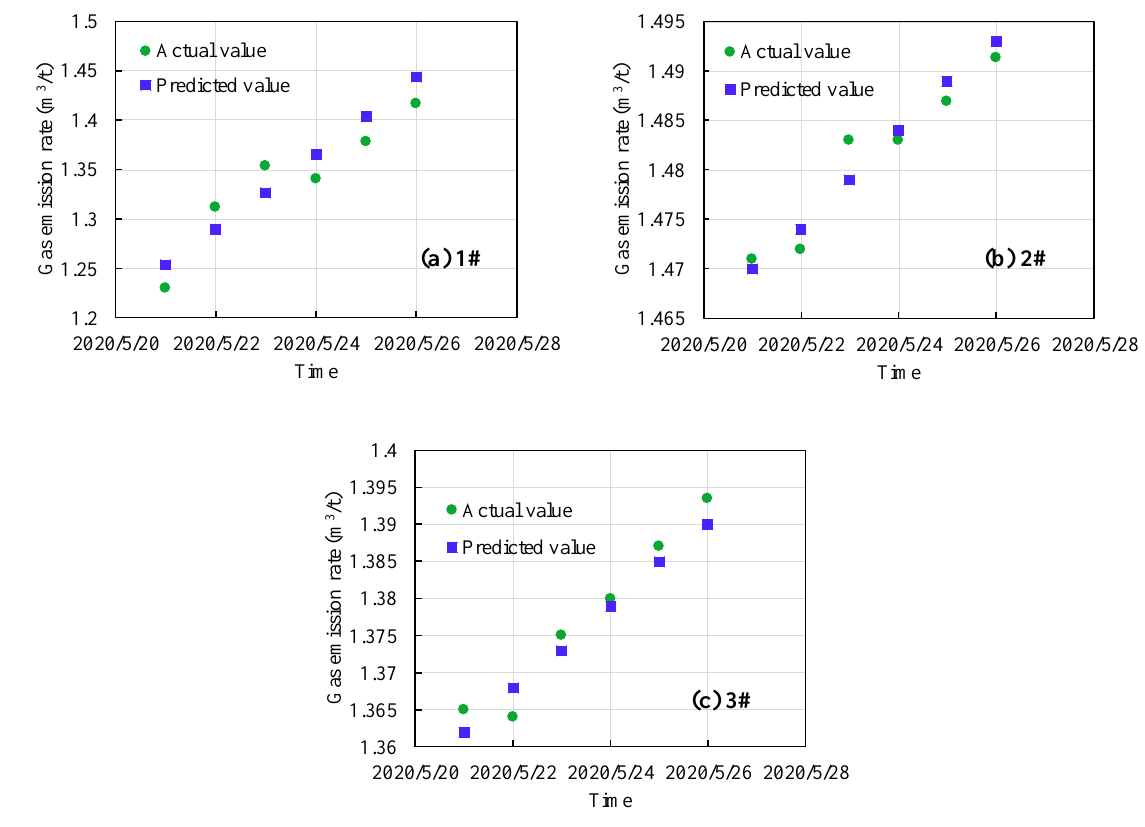
Figure 6. Comparison of gas prediction and actual data in the intake and return air roadways of the working face. ( a ) 1#